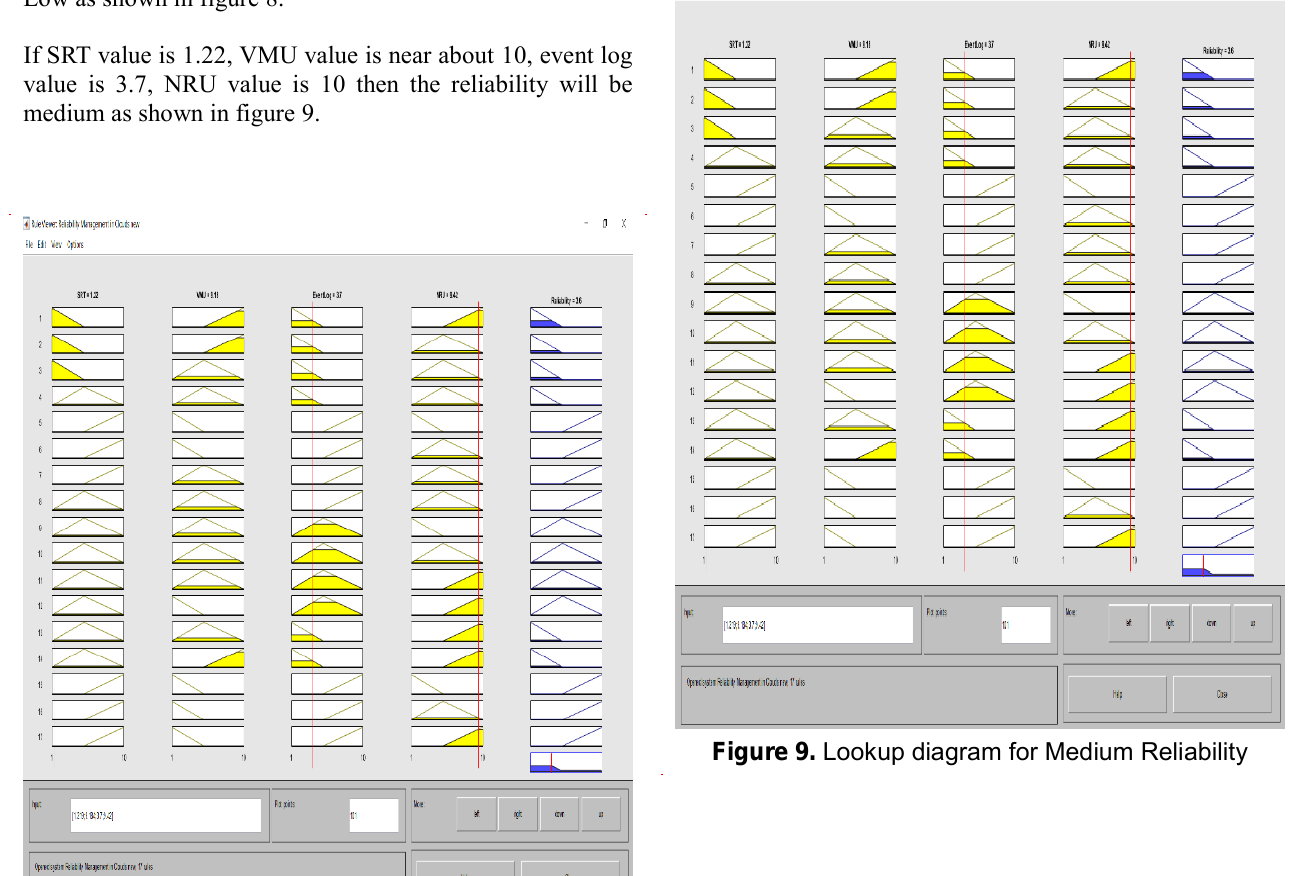
Figure 8. Lookup diagram for Low Reliability